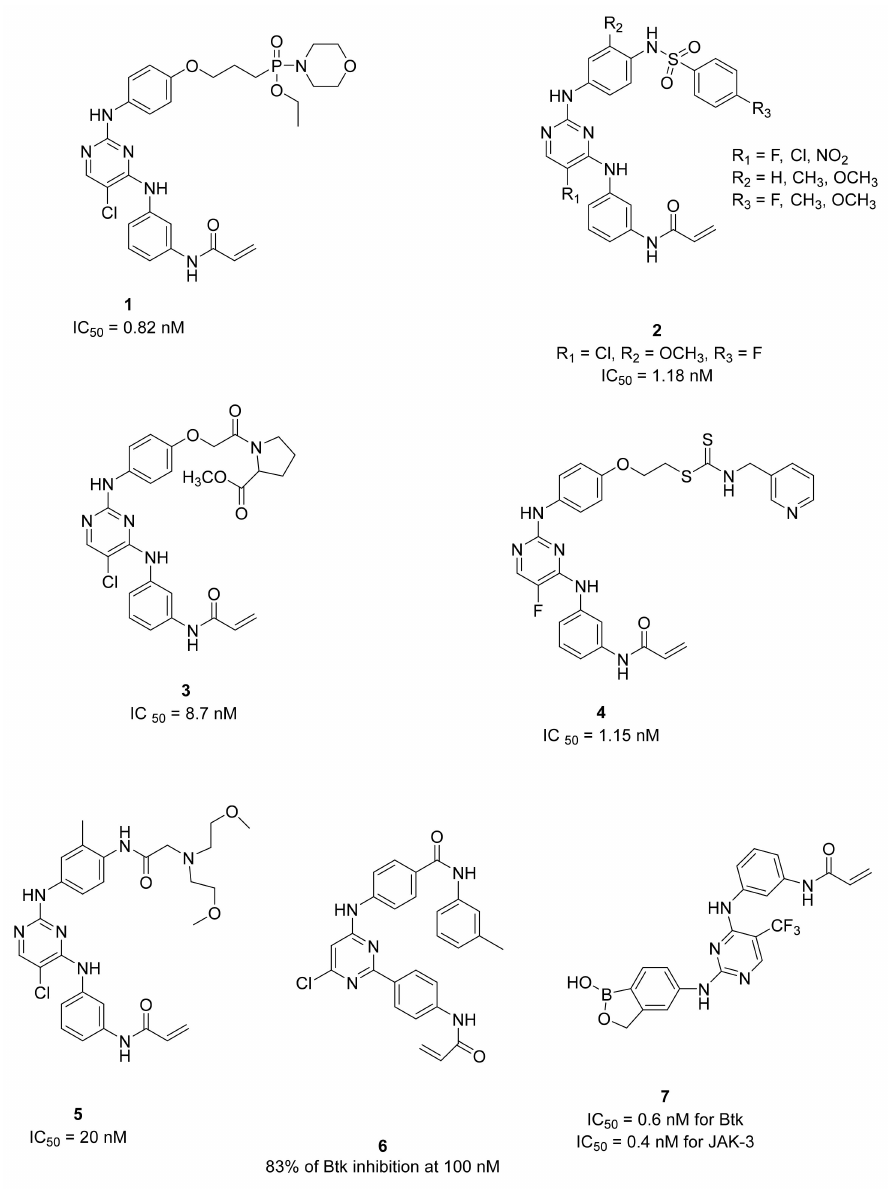
Figure 5. DPPYs reported as